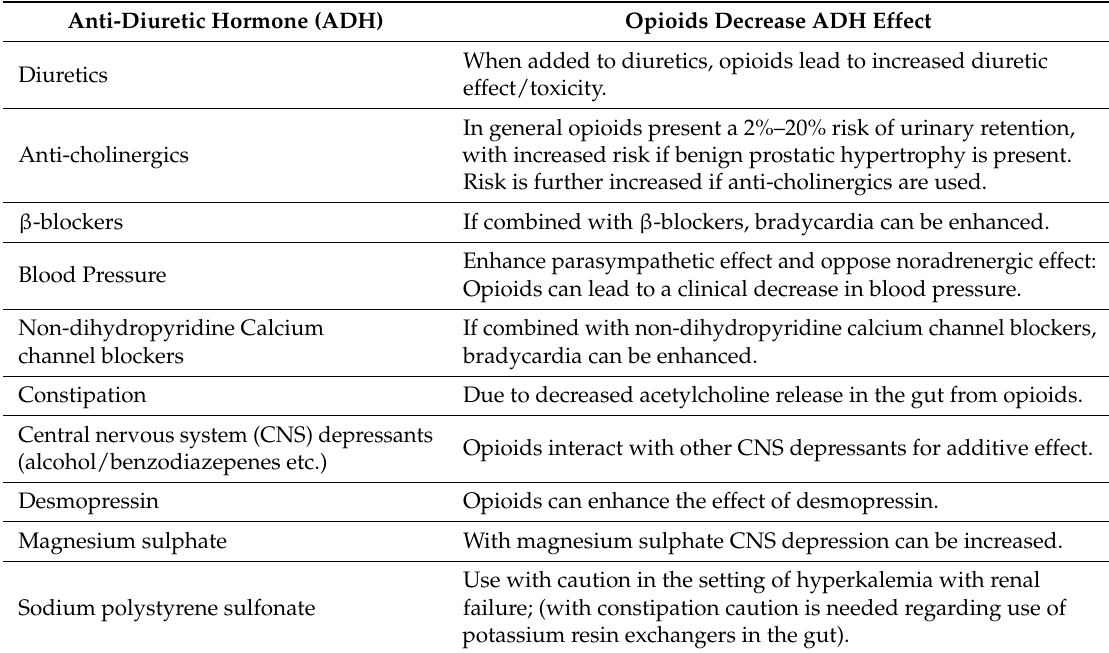
Table 3. Class effects of